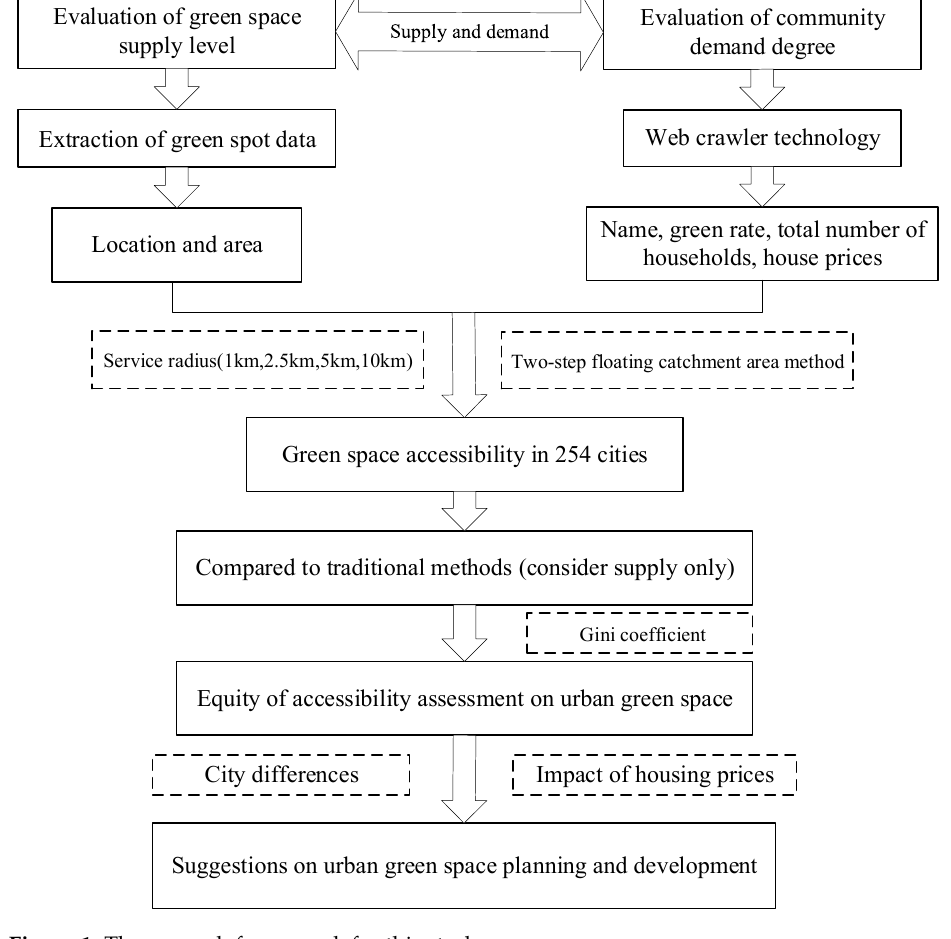
Figure 1. The research framework for this study.